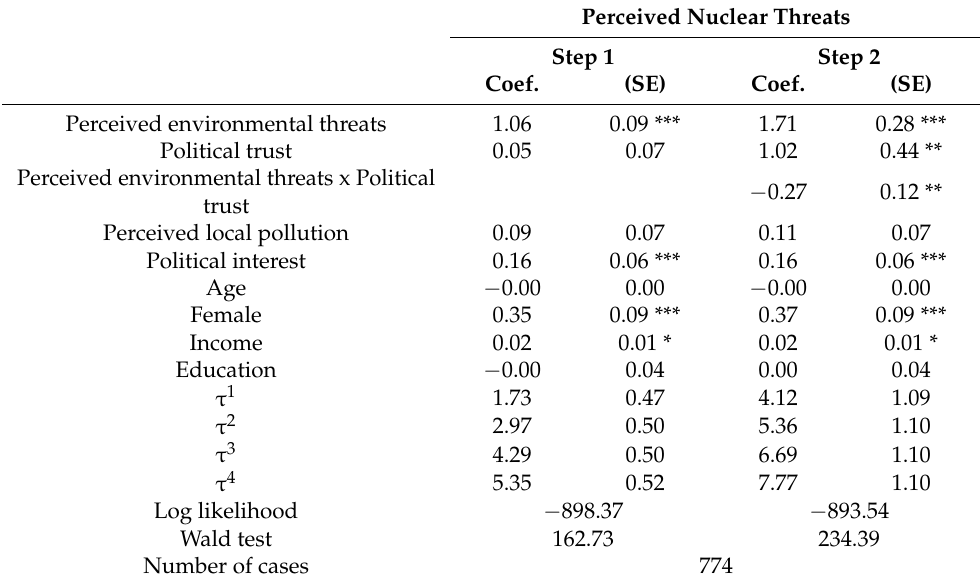
Table 2. Regression